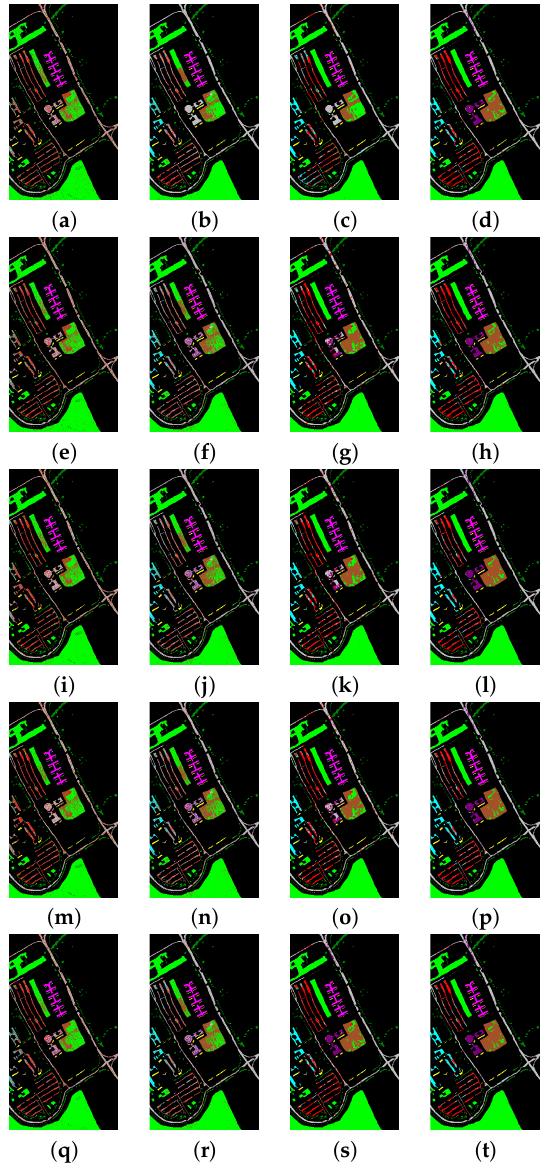
Figure 5. Classification maps for the Pavia University data set. ( a ) (cid:96) 2 + (cid:96) 1 ; ( b ) (cid:96) 2 + (cid:96) 1 +NC; ( c ) (cid:96) 2 + (cid:96) 1 +SF; ( d ) (cid:96) 2 + (cid:96) 1 +SF+NC; ( e ) (cid:96) 1 + (cid:96) 1 ; ( f ) (cid:96) 1 + (cid:96) 1 +NC; ( g ) (cid:96) 1 + (cid:96) 1 +SF; ( h ) (cid:96) 1 + (cid:96) 1 +SF+NC; ( i ) F + (cid:96) 1 ; ( j ) F + (cid:96) 1 +NC; ( k ) F + (cid:96) 1 +SF; ( l ) F + (cid:96) 1 +SF+NC; ( m ) F + (cid:96) 2,1 ; ( n ) F + (cid:96) 2,1 +NC; ( o ) F + (cid:96) 2,1 +SF; ( p ) F + (cid:96) 2,1 +SF+NC; ( q ) (cid:96) 2,1 + (cid:96) 2,1 ; ( r ) (cid:96) 2,1 + (cid:96) 2,1 +NC; ( s ) (cid:96) 2,1 + (cid:96) 2,1 +SF; ( t ) (cid:96) 2,1 + (cid:96) 2,1 +SF+NC